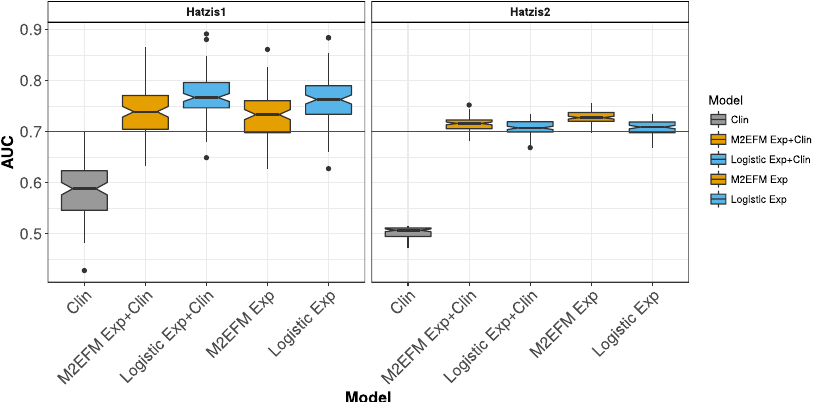
Figure 5. AUC for expression-only pCR models across 100 random splits of Hatzis1 data into training and testing data for the various approaches, which were then validated on Hatzis2. Although Logistic-Ridge models performed better on the internal validation models, M2EFM models performed better on external validation